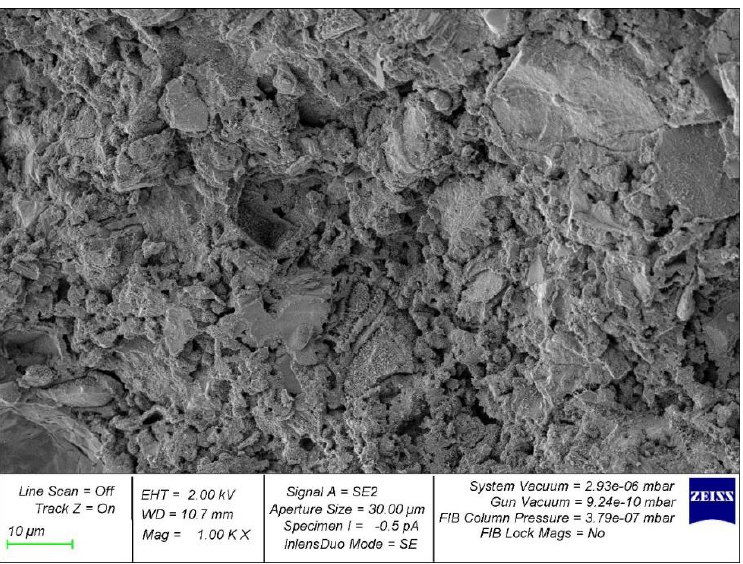
Figure 14. Sample with partial replacement of cement with eggshell powder at 30%.